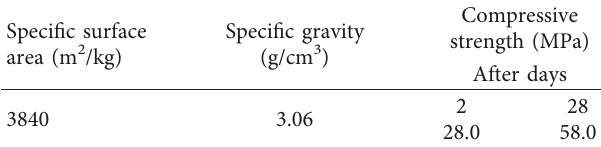
Table 3: Physical properties of cement.